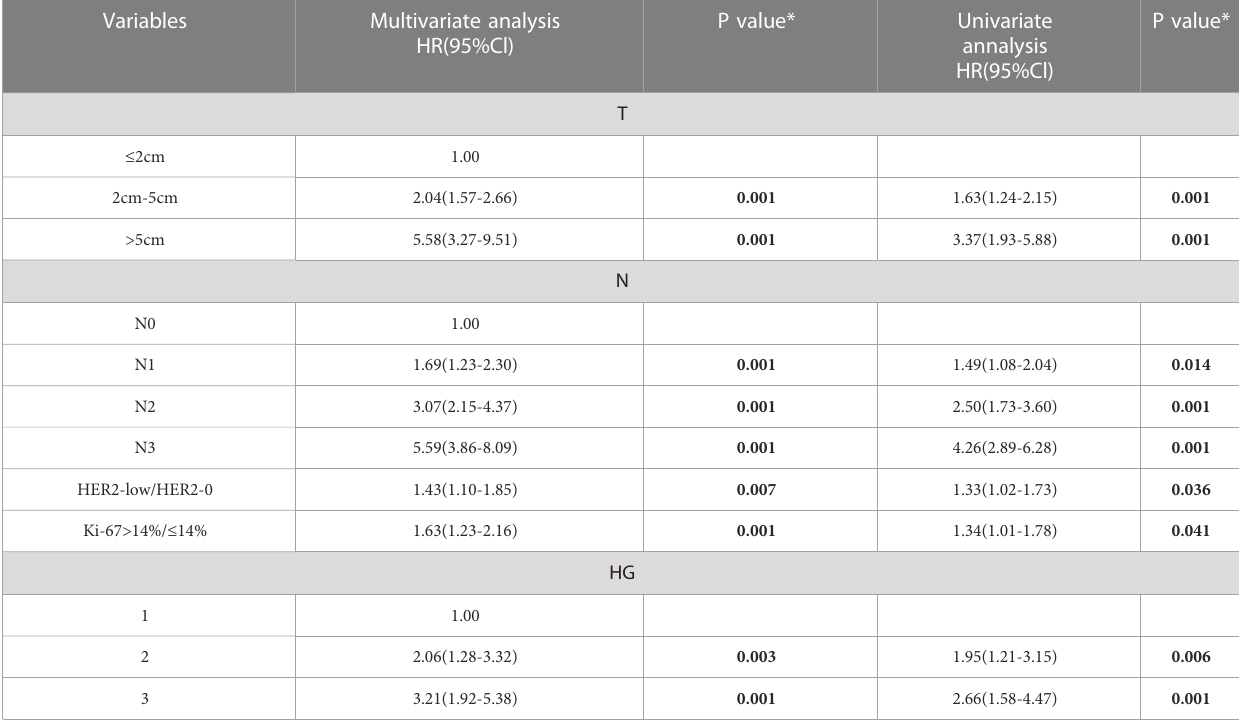
TABLE 3 Univariate and multivariate analyses for disease-free survival in the Hormone receptor-positive population. Variables